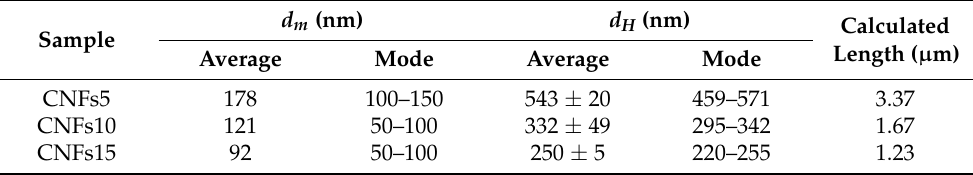
Table 2. Estimation of the dimensions (length and diameter) of